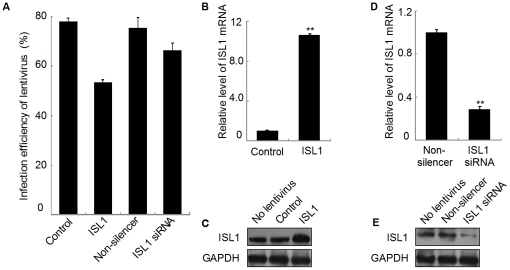
The expression of ISL1 was altered in adult islet mass by ISL1 overexpression or knockdown.(A) Infection efficiency (as indicated by the percentage of GFP positive cells in gated cells) of ISL1 overexpression lentivirus or ISL1-siRNA lentivirus were detected by flow cytometry analysis after 72 h infection. Real-time RT-PCR (B, D) and Western blotting (C, E) results showed the expression level of ISL1 in ISL1 overexpressed (B and C) islet cells and in ISL1 knockdown (D and E) islet cells. Data represent 3 independent experiments, each performed in triplicate. Each bar represents mean ± SD (**p<0.01, vs. the control). Lentivirus without any insert was used as a control.